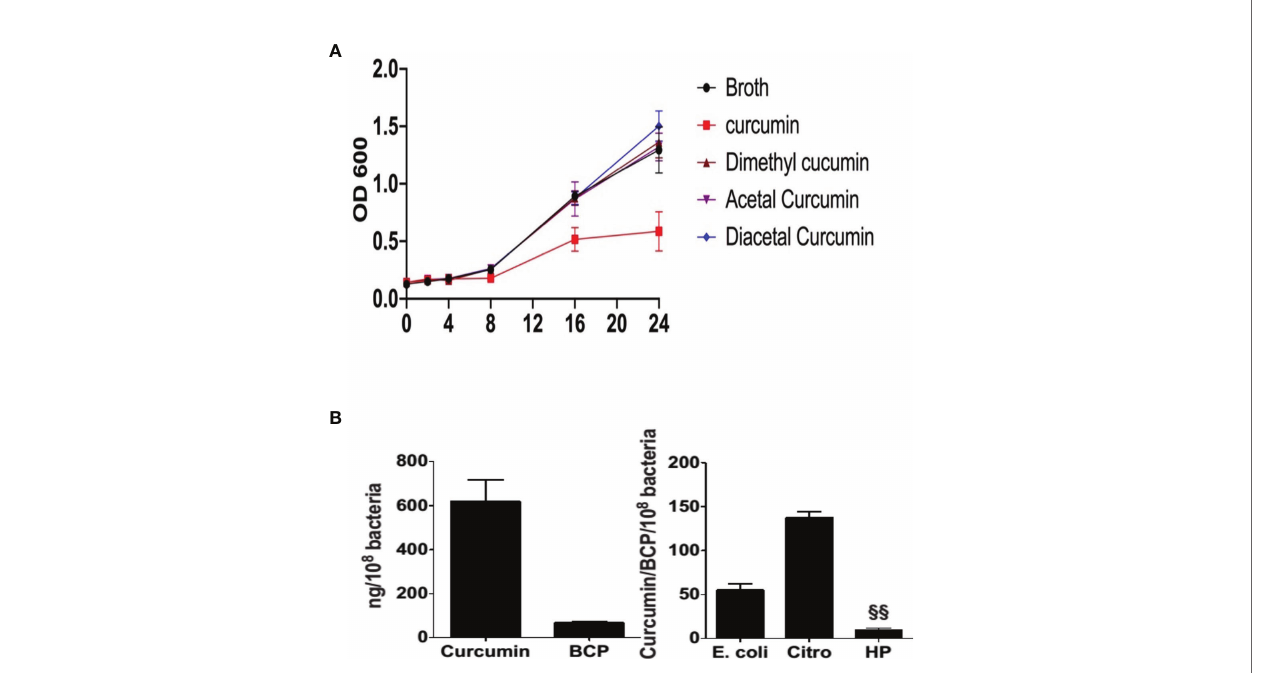
FIGURE 4 | Effect of curcumin and its stable analogs on growth of H. pylori and intracellular accumulation of bicyclopentadione (BCP) in H. pylori , E. coli, and Citrobacter rodentium (A) H pylori was grown in the absence or presence of curcumin, dimethyl-, acetal-, or diacetal-curcumin, and growth was determined by measuring optical density. (B) Intracellular accumulation of curcumin and BCP in H. pylori. (C) After 24hr treatment the ratio of accumulation of curcumin and BCP in E. coli, Citrobacter rodentium (Citro), and H. pylori (Hp). §§ P ≤